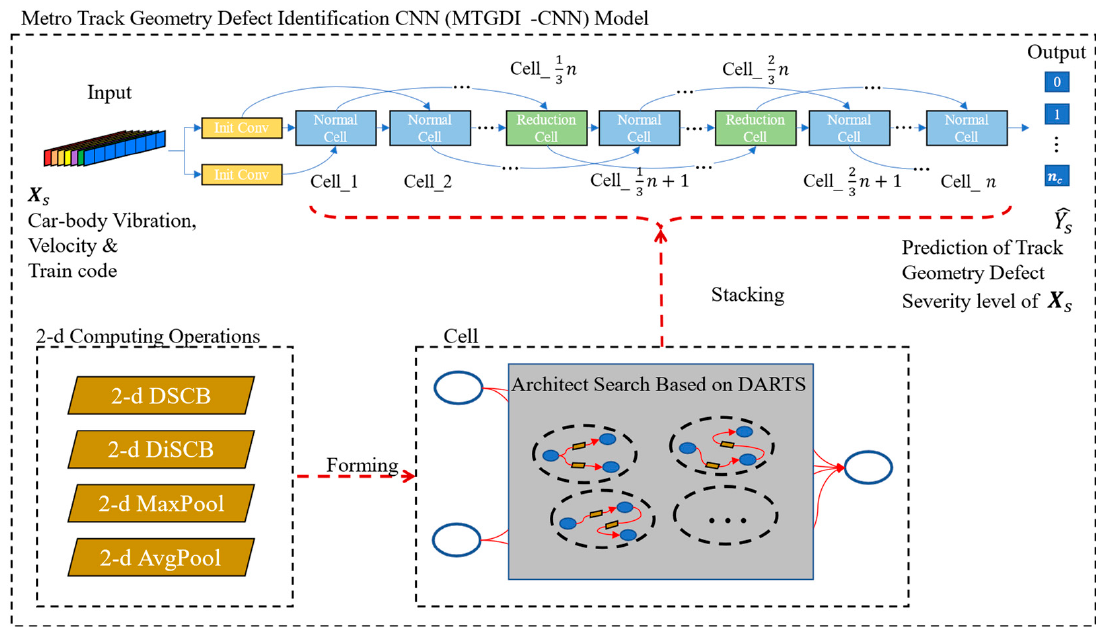
Figure 6. Structure of MTGDI-CNN based on DARTS optimization method.